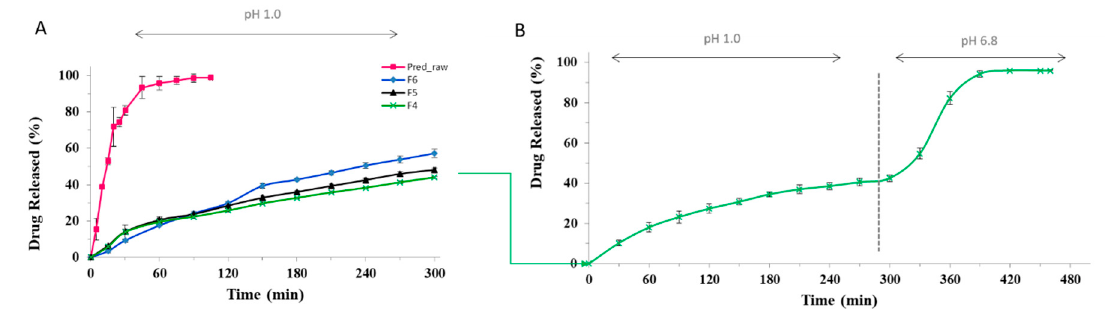
Figure 4. ( A ) Release profiles of Pred raw material compared with formulations F4, F5, and F6 in SGF for 5 h; ( B ) release profile of #F4 obtained with a change pH assay.